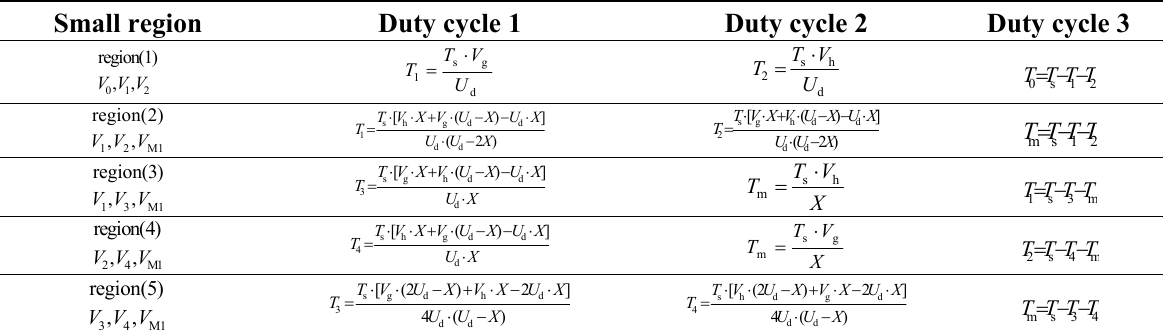
Table 2. Duty cycle of voltage vectors in sextant